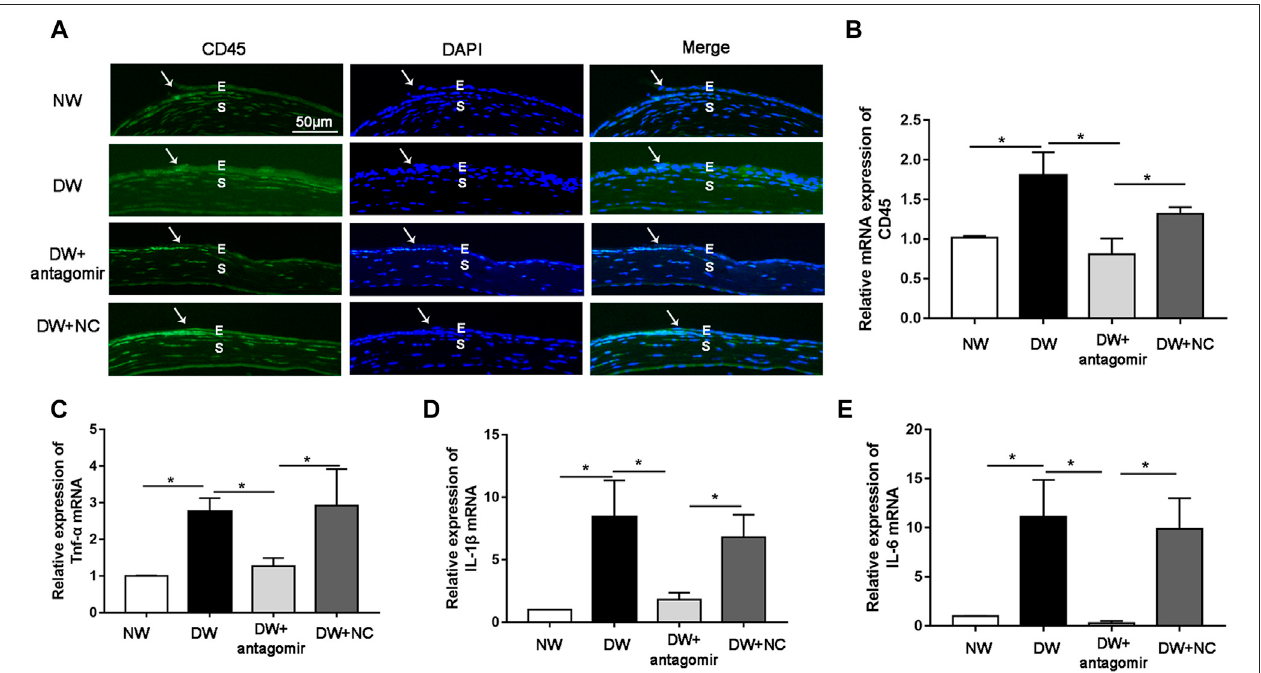
FIGURE 7 | miR-223-5p antagonist promoted diabetic corneal epithelial wound repair and nerve regeneration by modulating in fl ammatory process. (A) Immuno fl uorescence corneal staining re fl ected CD45 protein expression in the normal mice (NW group), diabetic mice (DW group), diabetic mice subconjunctivally injected with miR-223-5p antagomir (DW + antagomir group) or antagomir NC (DW + NC group) 24 h post-injury. (B) qRT-PCR results revealing the CD45 mRNA expression of thecorneal epithelium in each group. (C – E) qRT-PCR detected the mRNA expression of in fl ammatory factors including TNF- α , IL-1 β , and IL-6 in the corneal epithelium of these four groups at 24 h post-wounding. (B – E) Data were analyzed by one-way ANOVA. If signi fi cant, multiple comparations were then performed. * p -value of < 0.05.